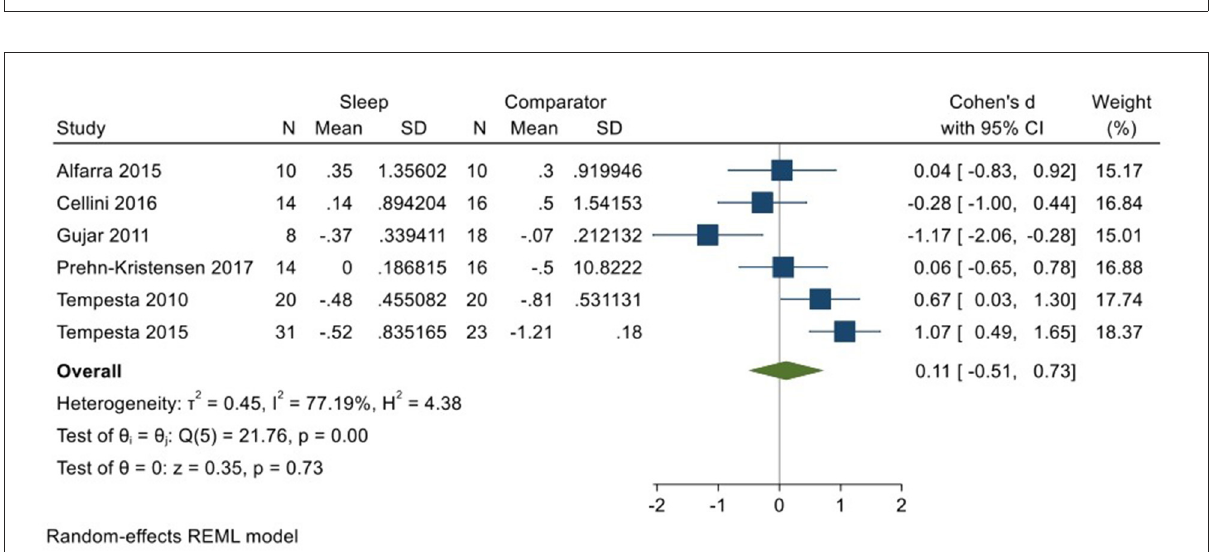
FIGURE7 Meta-analysis IV: Outcomes for self-reported valence in response to neutral stimuli – changes across a period of sleep compared to across a period of waking ( K = 11, N = 405).